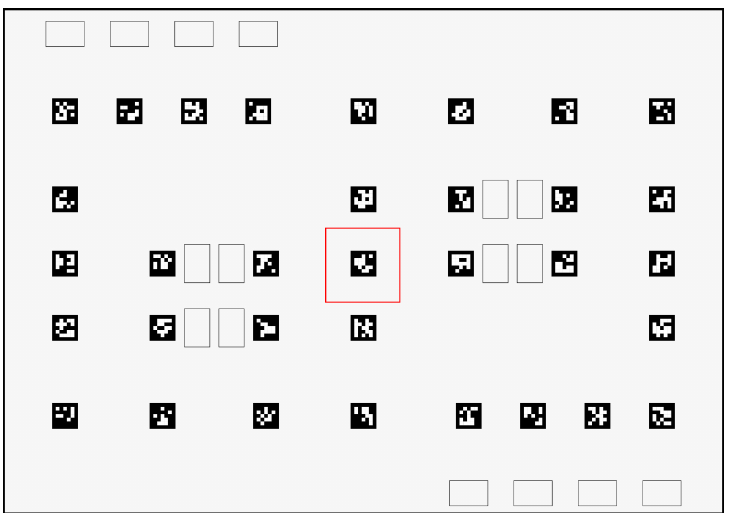
Figure 7. Part of the field used to collect images for the tests to show the relationship between the grid resolution and errors.